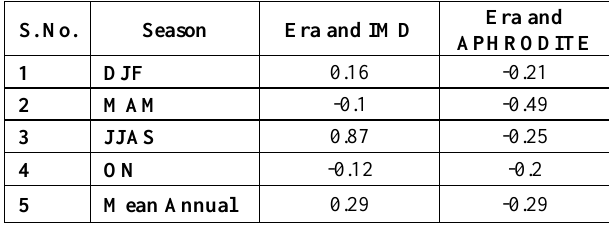
Table 5. Bias between Era-Interim against IMD and APHRODITE rainfall